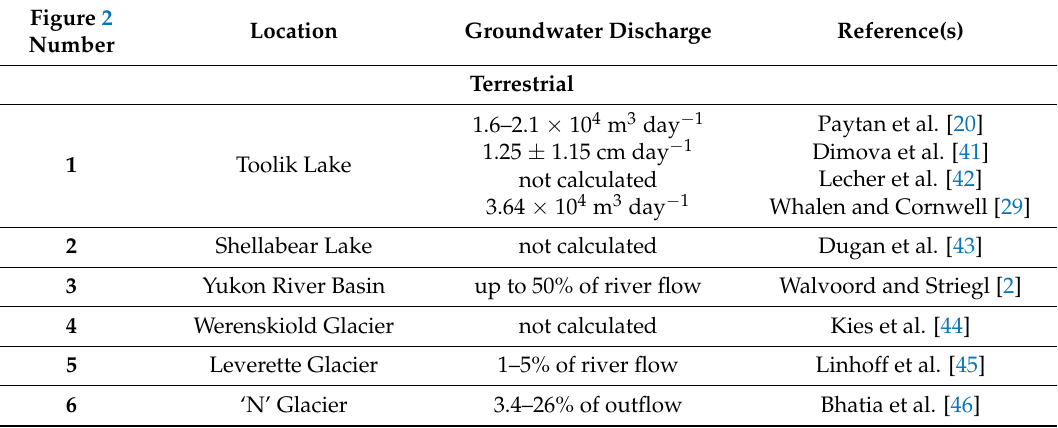
Table 1. Study sites of Arctic groundwater